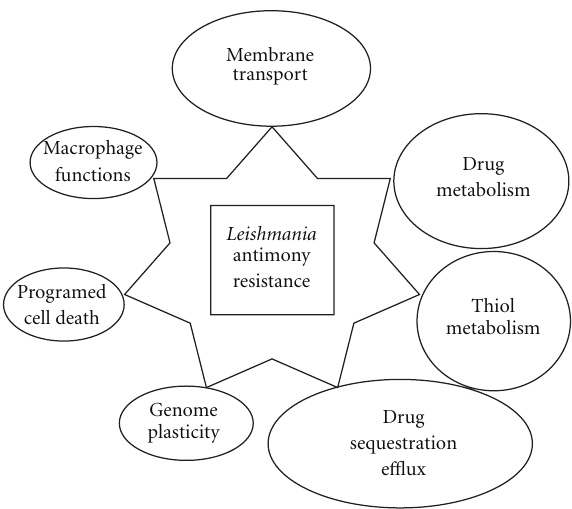
Figure 1: Main pathways involved in Leishmania